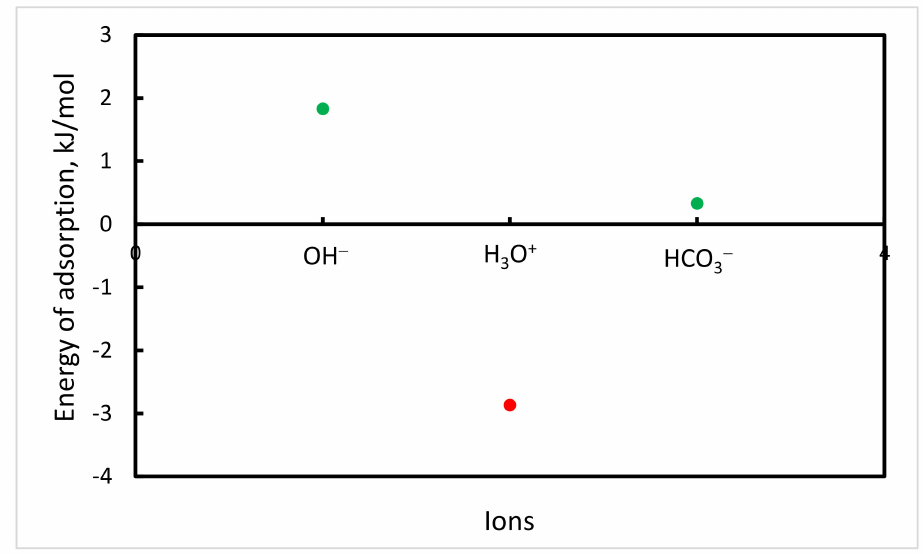
Figure 3. Energies of adsorption of OH − , H 3 O + , and HCO 3 − ions on the air / water interface.